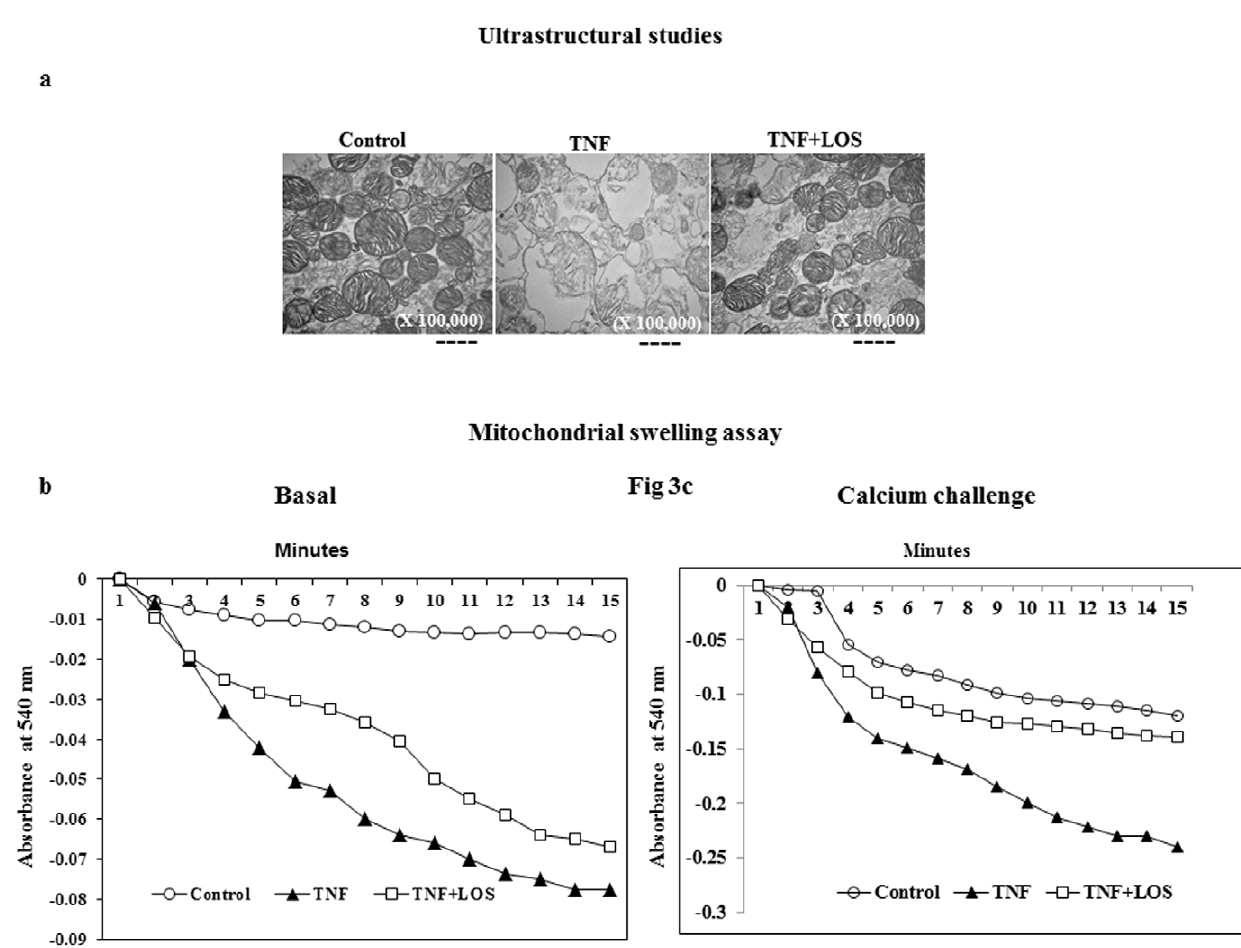
Figure 3. Representative electron micrographs of isolated rat heart mitochondria from each experimental group. a) Heart mitochondria from the TNF group demonstrated loss of outer and inner membrane structure, disordered cristae, and vacuolization. Note that the heart mitochondria from losartan-treated rats had a normal appearance. b) In the absence of and c) in the presence of a 50 mM calcium challenge. Heart mitochondria from rats given TNF demonstrated more swelling, which was indicative of disordered permeability transition. (Figure 5f) in TNF + LOS treated rats compared with TNF treated rats. These results further suggest that the interaction of TNF and ANG II induces cardiac mitochondrial oxidative damage, leading